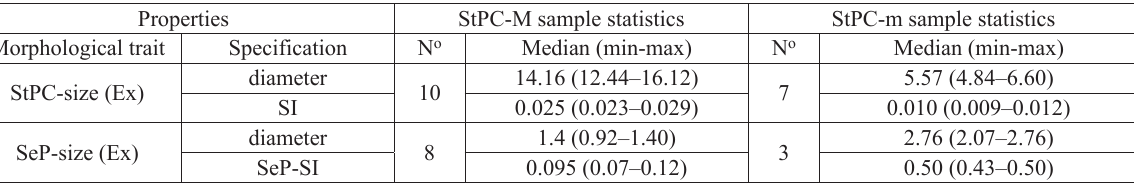
Table 4. Characterization of sieve-type normal pore canals (StPC) of Minyocythere tuberculata (Luppold, 2012). Abbreviations: StPC-M, macro sieve-type pore canals; StPC-m, micro sieve-type pore canals; Ex/In, view of the trait on the external/internal side of the valve; SI, Size Index (ratio of the pore diameter to the valve’s length); SeP, setal pore of the StPC; SeP-SI, Setal Pore Size Index (ratio of the SeP diameter to the StPC diameter); diameter (in μ m), expressed either as individual value or through the median statistics and min-max values; N o , number of